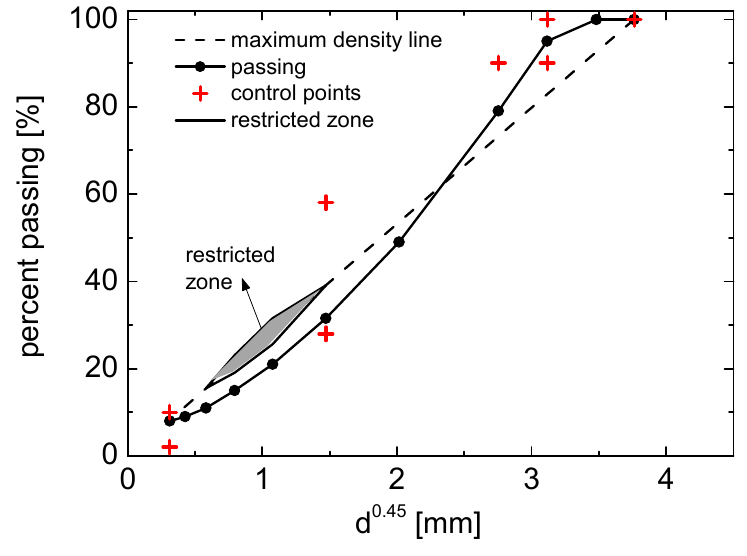
Figure 1. Aggregate gradation used for the asphalt concretes specimens’ productions.